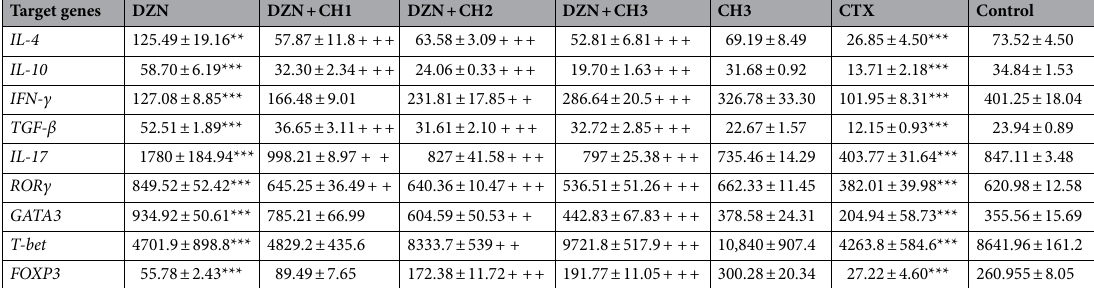
Table 6. The results of DZN 20 mg/kg, CH 50 mg/kg and CH and DZN plus CH (12.5, 25, and 50 mg/kg) on cytokine gene expression in BALB/c mice. Data showed as mean ± SD, (*) shows the significant changes compared to controls, ( +) comparison with DZN-treated group. p < 0.05 and (***) or (+ + + +) p < 0.001. RT-qPCR, EvaGreen method was used to study the gene expression as transcription factors and cytokine for Th subpopulations (Th1, Th2, Th17, Treg). Data showed the increased expression of IL-4 , IL-10 , IL-17 , TGF-β , GATA3 , and RORγt genes in the DZN treated group compared to the control group. However, CH was able to up-regulate the toxic effect of DZN. On the other hand, DZN significantly down-regulated the expression of IFN-γ , FOXP3 and T-bet genes. However, CH could substantially modulate the decrement effect of DZN on these factors at different